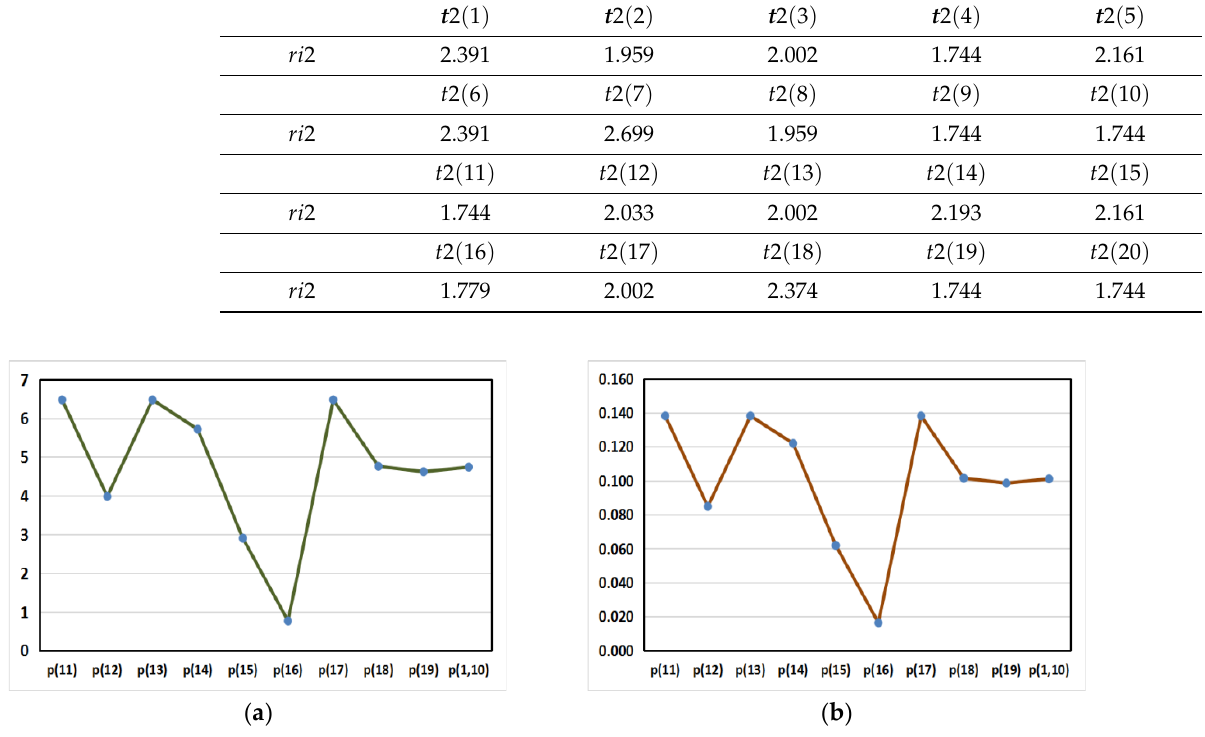
Figure 4. The fluctuating histograms for the needs absolute weight f ( i 1, j ) and relative weight ∇ f ( i 1, j ) . ( a ) shows the tourist-needs absolute weight f ( i 1, j ) . ( b ) shows the tourist-needs relative weight ∇ f ( i 1, j ) .